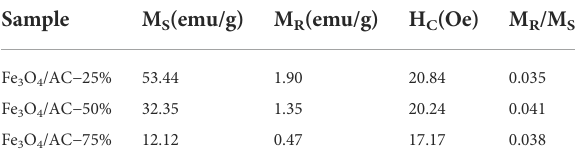
TABLE 2 Magnetic parameters of samples measured by